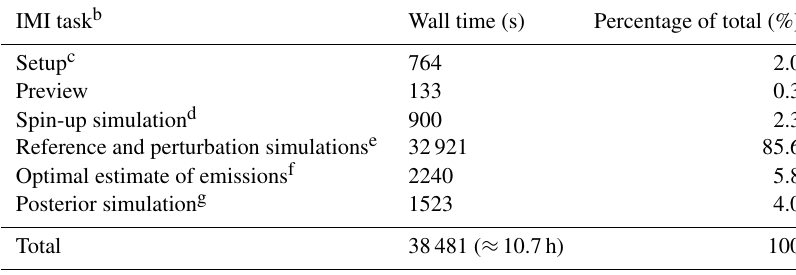
Table 3. Breakdown of IMI runtime by task for a 1-month Permian Basin inversion (May 2018) a